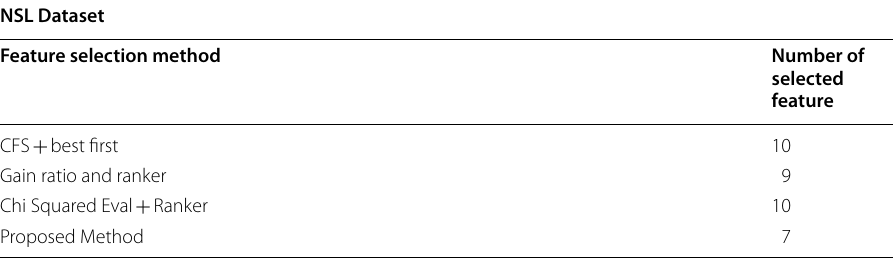
Table 15 The number of selected features by common method and proposed method NSL Dataset